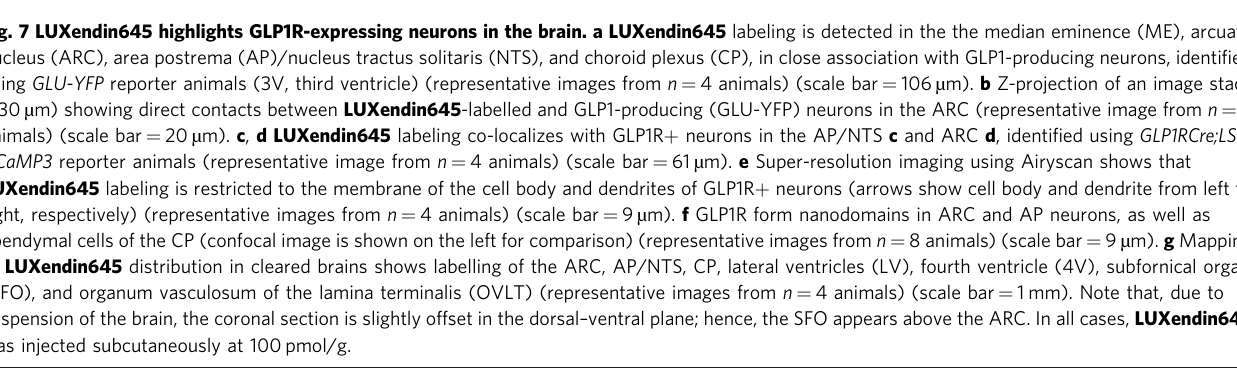
Fig. 7 LUXendin645 highlights GLP1R-expressing neurons in the brain. a LUXendin645 labeling is detected in the the median eminence (ME), arcuate nucleus (ARC), area postrema (AP)/nucleus tractus solitaris (NTS), and choroid plexus (CP), in close association with GLP1-producing neurons, identi fi ed using GLU-YFP reporter animals (3V, third ventricle) (representative images from n = 4 animals) (scale bar = 106 µ m). b Z-projection of an image stack (~30 µ m) showing direct contacts between LUXendin645 -labelled and GLP1-producing (GLU-YFP) neurons in the ARC (representative image from n = 4 animals) (scale bar = 20 µ m). c , d LUXendin645 labeling co-localizes with GLP1R + neurons in the AP/NTS c and ARC d , identi fi ed using GLP1RCre;LSL- GCaMP3 reporter animals (representative image from n = 4 animals) (scale bar = 61 µ m). e Super-resolution imaging using Airyscan shows that LUXendin645 labeling is restricted to the membrane of the cell body and dendrites of GLP1R + neurons (arrows show cell body and dendrite from left to right, respectively) (representative images from n = 4 animals) (scale bar = 9 µ m). f GLP1R form nanodomains in ARC and AP neurons, as well as ependymal cells of the CP (confocal image is shown on the left for comparison) (representative images from n = 8 animals) (scale bar = 9 µ m). g Mapping of LUXendin645 distribution in cleared brains shows labelling of the ARC, AP/NTS, CP, lateral ventricles (LV), fourth ventricle (4V), subfornical organ (SFO), and organum vasculosum of the lamina terminalis (OVLT) (representative images from n = 4 animals) (scale bar = 1 mm). Note that, due to suspension of the brain, the coronal section is slightly offset in the dorsal – ventral plane; hence, the SFO appears above the ARC. In all cases, LUXendin645 was injected subcutaneously at 100